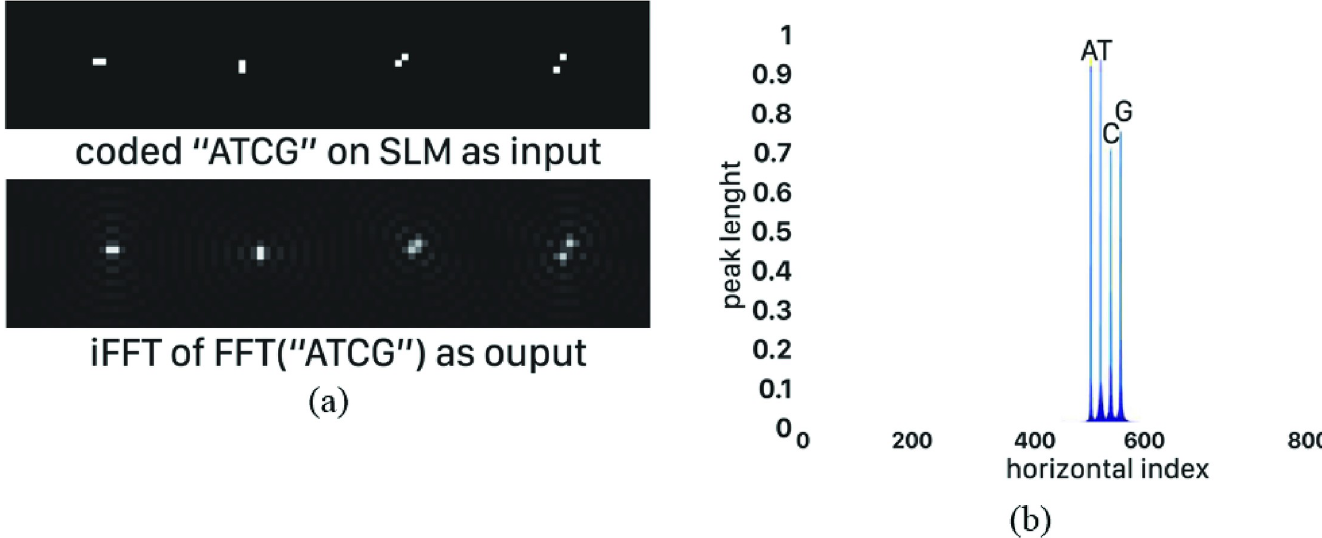
Fig 12. Effect of lens choice on FFT noise of sequence "ATCG" coded with coding set with d = 3, N = 2, E = 0 and score equal to 0. a) Input and output patterns, note halo created around each code at the output pattern, b) Different peak values for various coding.